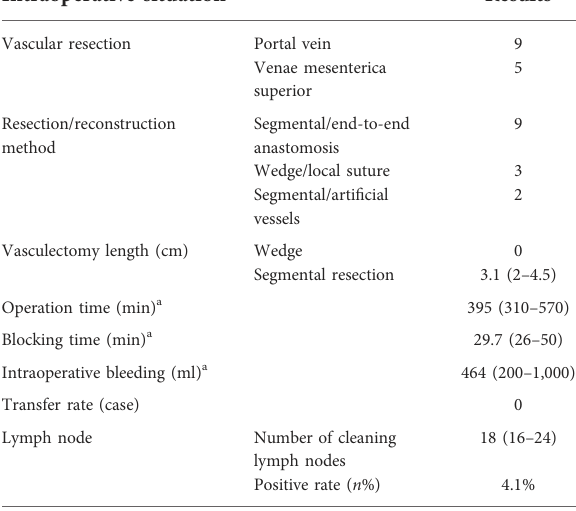
TABLE 2 Intraoperative